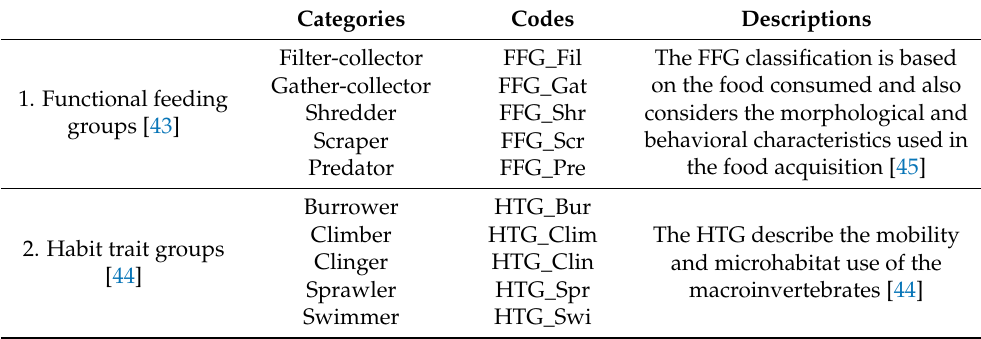
Table 1. Macroinvertebrates’ traits, their descriptions, codes, and categories used in this